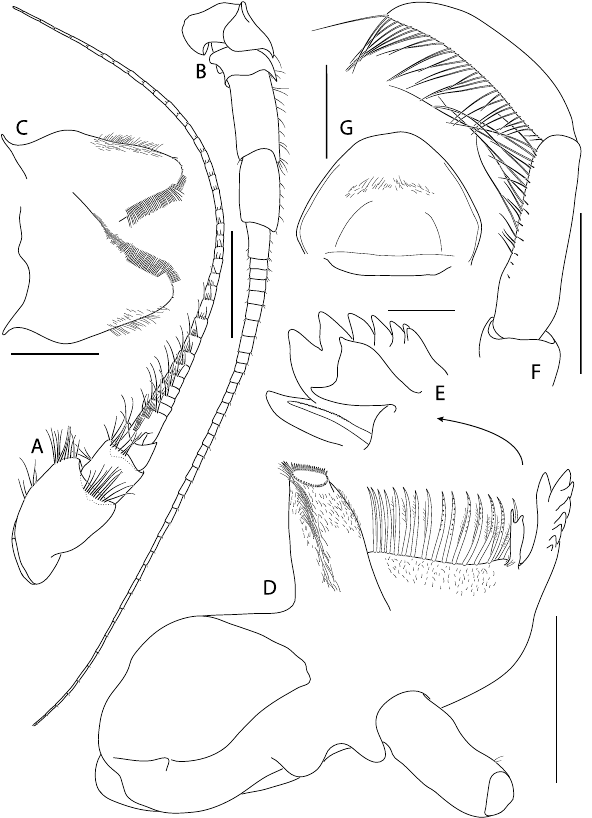
Figure 15. Epimeria cornigera , neotype, adult female, northern North Sea, NHMUK 2015.3268: ( A ) antenna 1, ( B ) antenna 2, ( C ) hypopharynx, ( D ) mandible, ( E ) mandible incisor and lacina mobilis, ( F ) mandibular palpus, ( G ) labrum; scales: (A,B) 1 mm; (C,D,F,G) 0.5 mm; (E) 0.1